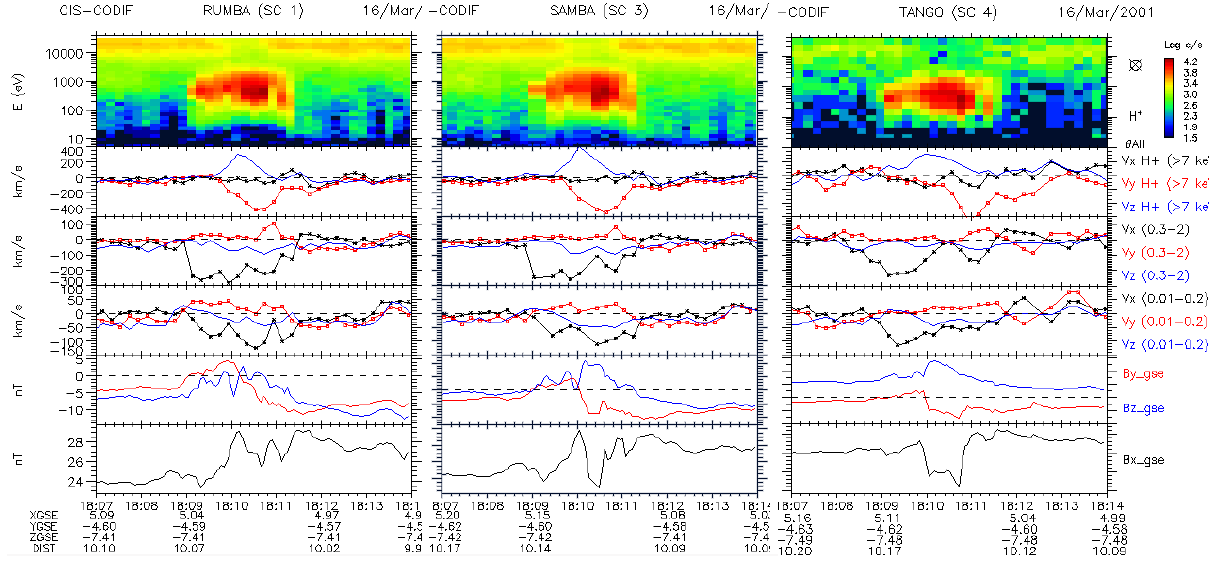
Fig. 4. A PTE from 16 March 2001, observed well inside the magnetosphere and apparently embedded in plasma sheet/ring current plasma. The injected magnetosheath ions (0.3–2keV) are still streaming essentially anti-sunward with a velocity of about 200km/s while the back- ground plasma is either streaming only moderately or just responding to the plasma gradient ( > 7keV). IMF: B z ≈ 1nT, B y ≈